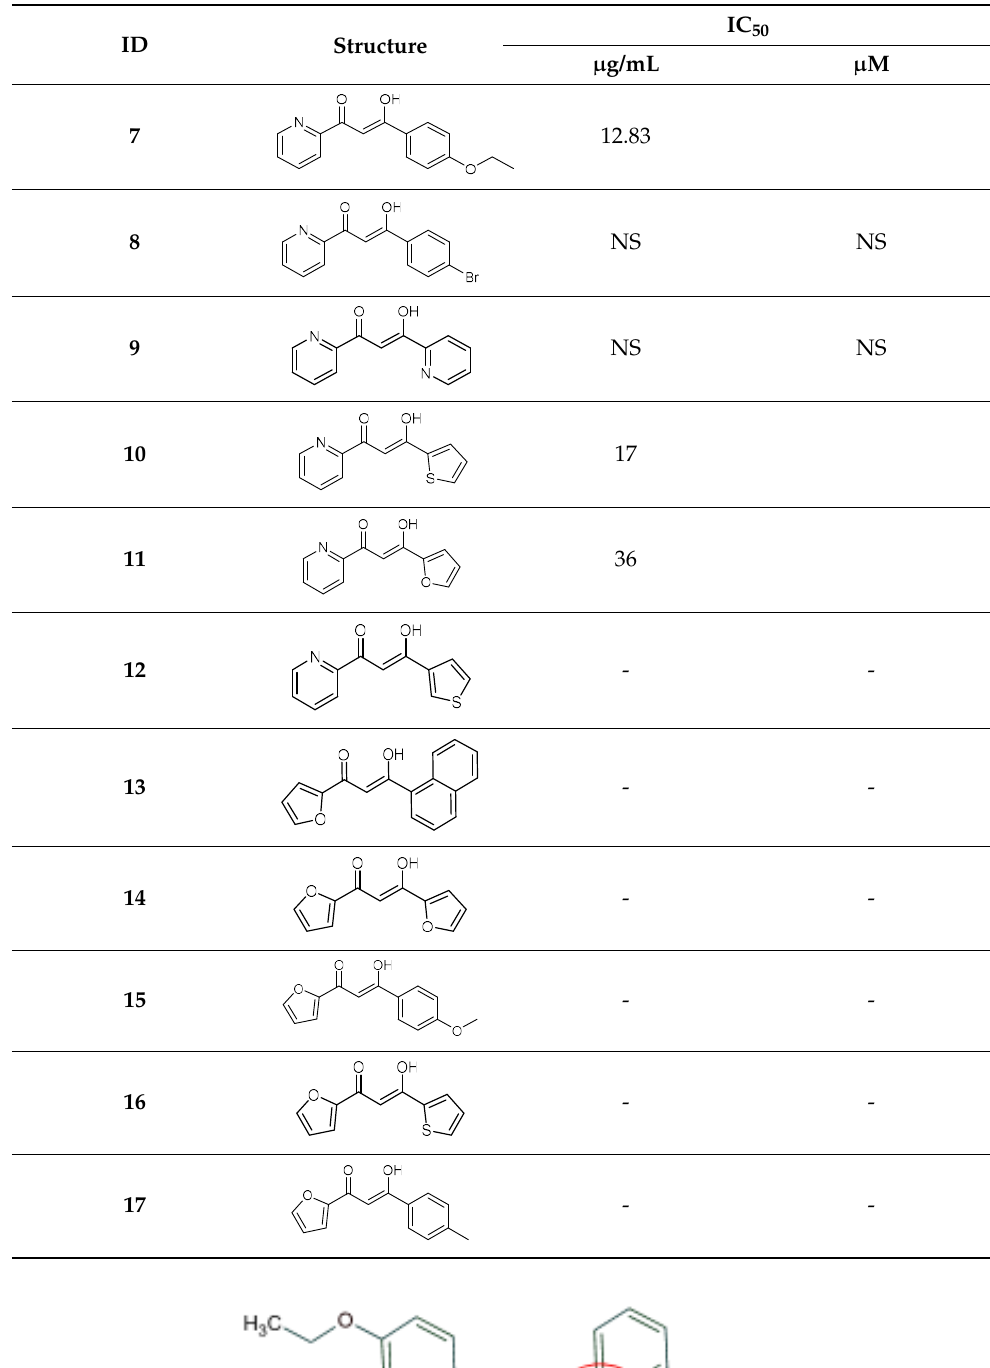
Table 2. IC 50 values of the tested β keto-enol pyridine and furan derivatives against F.o.a. Table 2. IC 50 values of the tested βketo-enol pyridine and furan derivatives against F.o.a. Table 2. IC Table 2. IC 50 values of the tested βketo-enol pyridine and furan derivatives against F.o.a. 50 values of the tested βketo-enol pyridine and furan derivatives against F.o.a. ID